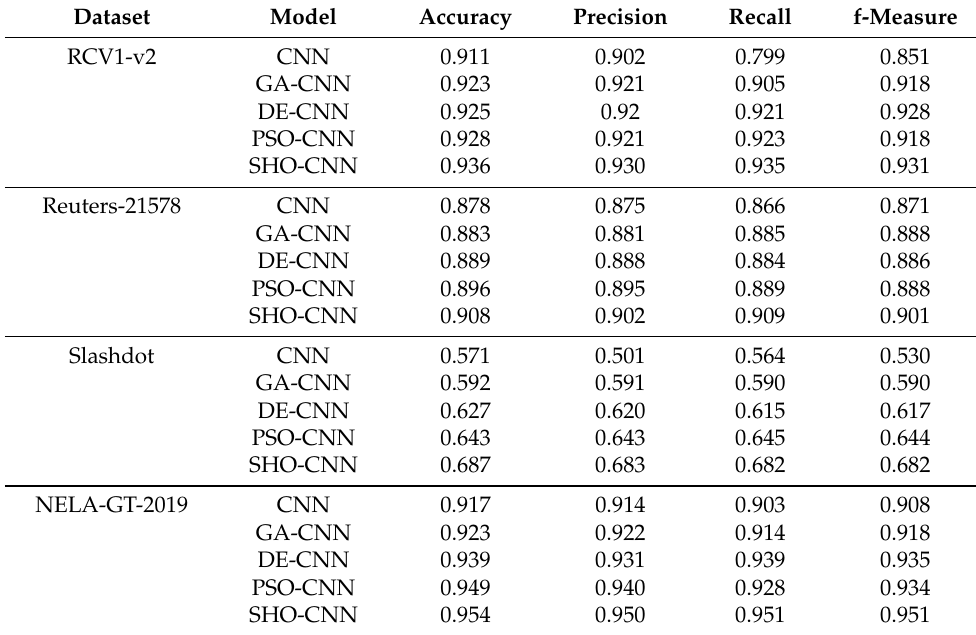
Table 5. Multi-label text news dataset